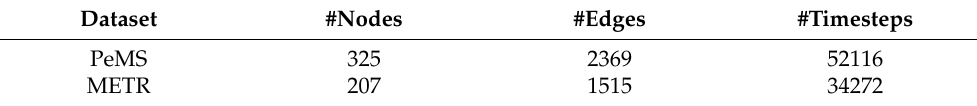
Table 1. Summary statistics of two real world datasets. We count the numbers of nodes, edges and timesteps in both the PeMS and METR datasets and organize them into tables. Dataset #Nodes #Edges #Timesteps PeMS 325 2369 52116 METR 207 1515